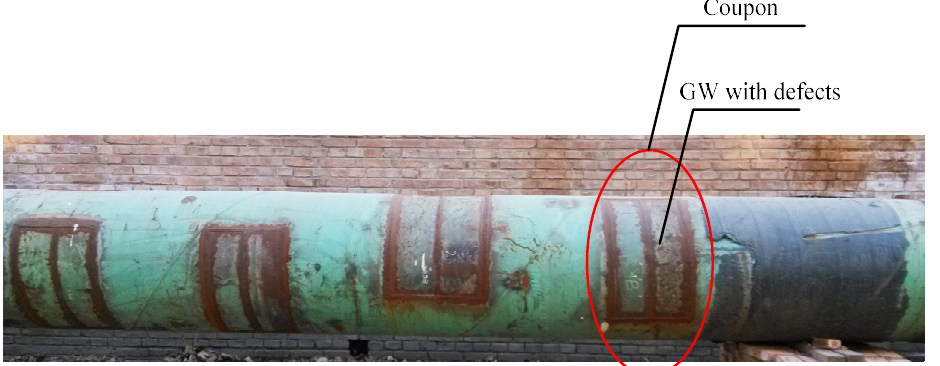
Figure 3. Circumferential crack-like pieces.